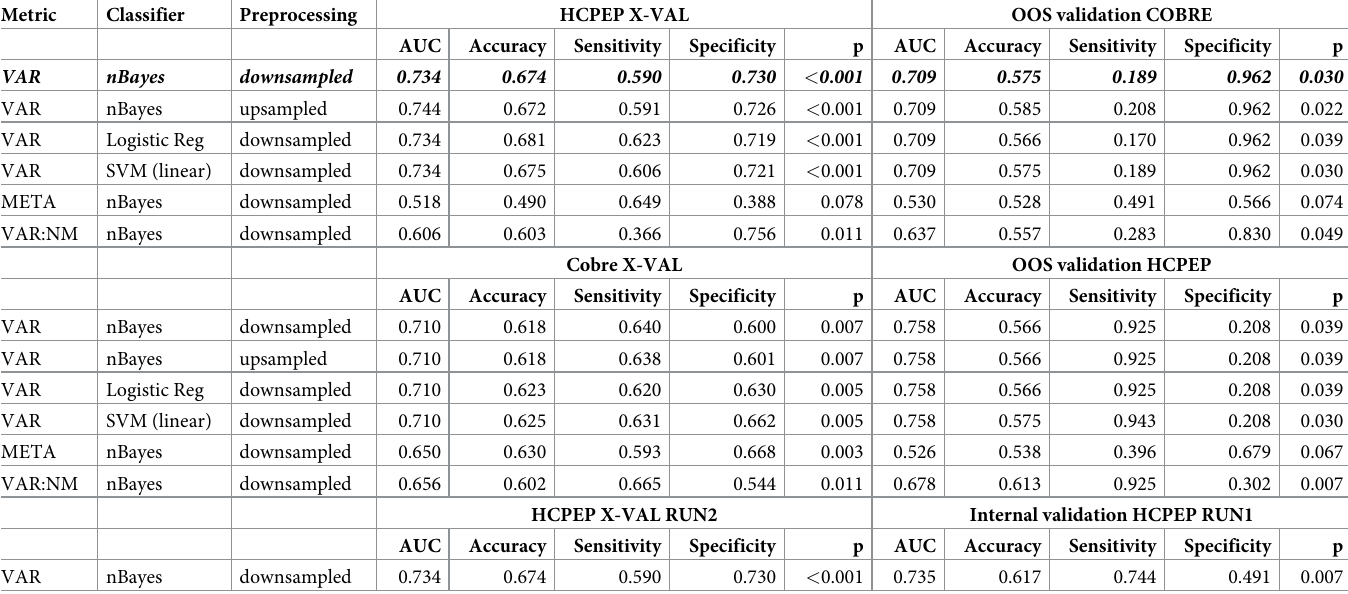
Table 5. Pserformance of additional classifiers in comparison to the classifier used in this